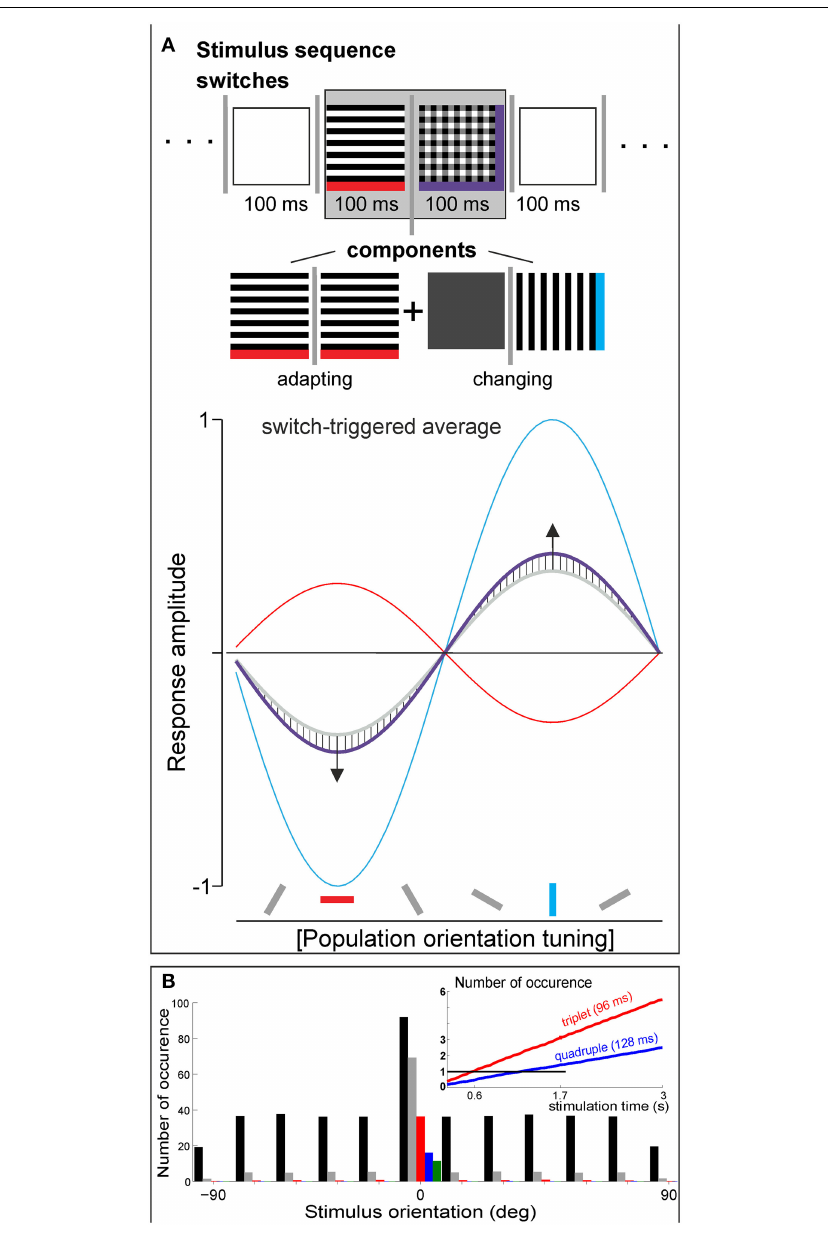
FIGURE 1 | (A) In Nortmann et al. (2013), pseudorandom stimulus sequences of 17 stimuli (vertically and horizontally filtered natural images, their superpositions, and isoluminant gray image) were presented at 10Hz ( > 64 shuffled repetitions). For switch-triggered averaging, sequences were aligned to a specific switch between a pair of stimuli, here to a switch from a single orientation to superimposed horizontal and vertical orientations (see sketch in gray box at top). Plot depicts fitted V1 population tuning curves for adaptive component (red), changing component (blue), and composite switch (purple curve, median across 12 different experiments). Hatched areas indicate deviations ( ∼ 20%) from the component average (gray). (B) Introducing a bias in one orientation (“adapter”) across random sequences of differently oriented gratings. A simple permutation test was done: adapter bias was set to 30% probability, 12 different orientations were simulated (100 repetitions), single frame = 32ms, overall stimulation time was 20s (#625 frames), as used in Benucci et al. (2013). Number of adapter occurrences as single, doublet, triplet, quadruple, and quintuple (black, gray, red, blue, and green, respectively). Inset: number of counts (black horizontal line represents N = 1) for 96 and 128ms periods of adapter stimulation after 3s of sequence presentation. After 0.6s, probability is enhanced to include at least one triplet (red; cf. start of adaptation effect in Supplementary Figure 5 of Benucci et al., 2013). After 1.7s, a presence of quadruple is likely (blue); variance was smaller than line